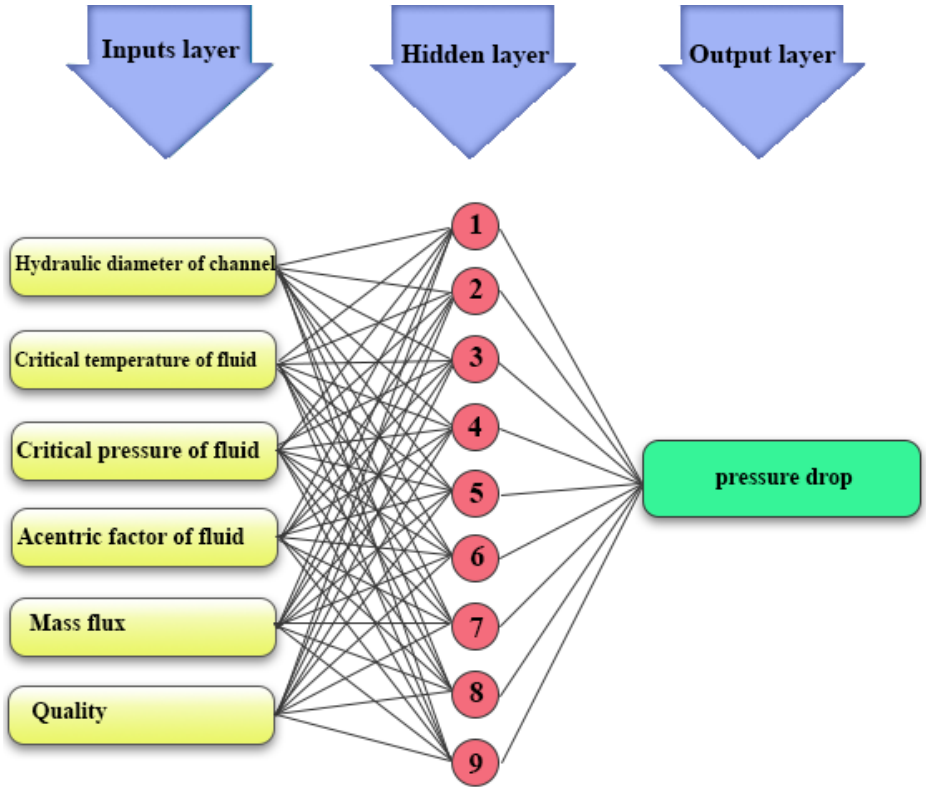
Figure 1. Schematic structure of the artificial neural network for estimating pressure drop.